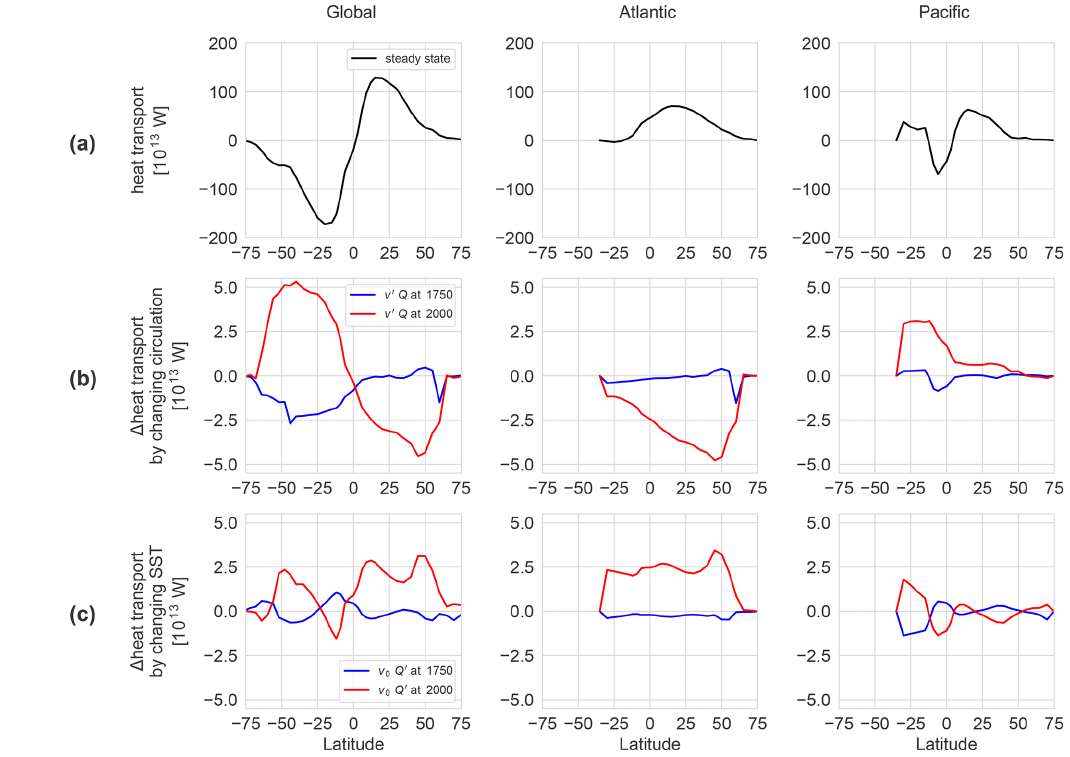
Figure 5. (a) Global and basin northward meridional heat transport in the ocean at steady state, OcFIX ( t = 1200). Meridional heat transport anomaly due to (b) changing circulation and (c) changing SST. The coldest time of the LIA is shown in blue (1750CE) and the industrial warming phase in red (2000CE). Note the different order of magnitude on the y axis. Results are derived from simulations OcTRA and OcFIX (see text) and variables v and Q refer to Eq.